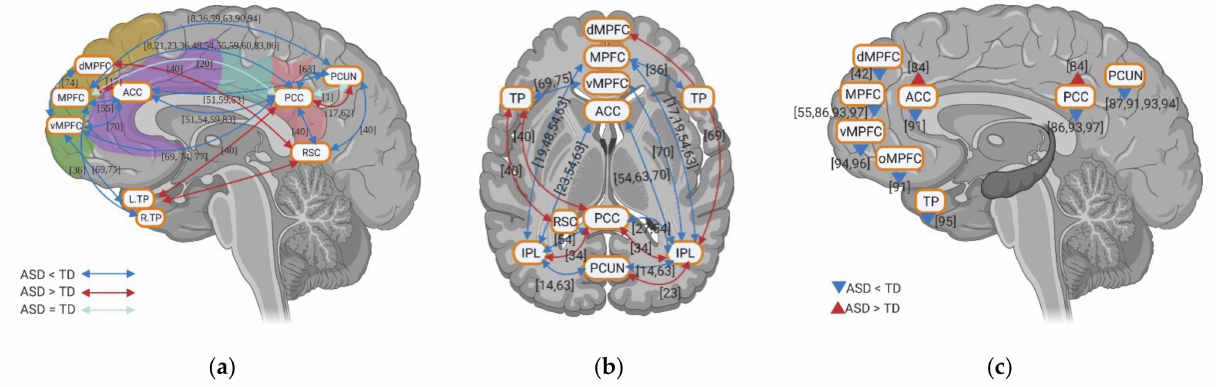
Figure 3. Inter-regional functional connectivity ( a , b ) and whole-brain resting state functional connectivity ( c ) of DMN for individuals with ASD compared to TD. The numbers in the figure correspond to the study numbers in Table 2.